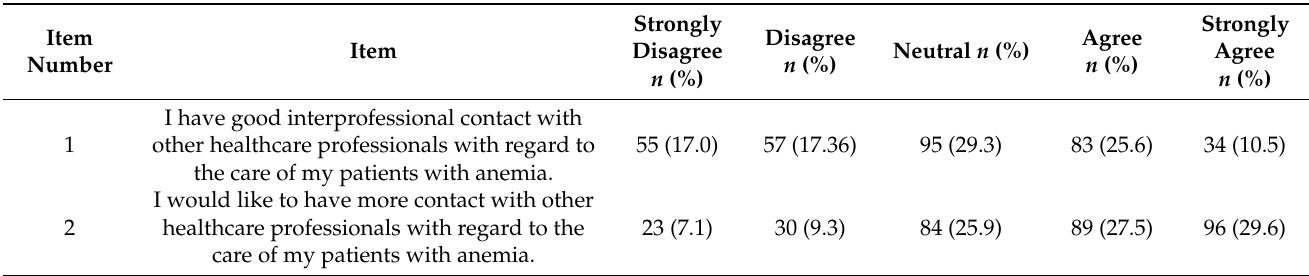
Table 7. Inter-professional